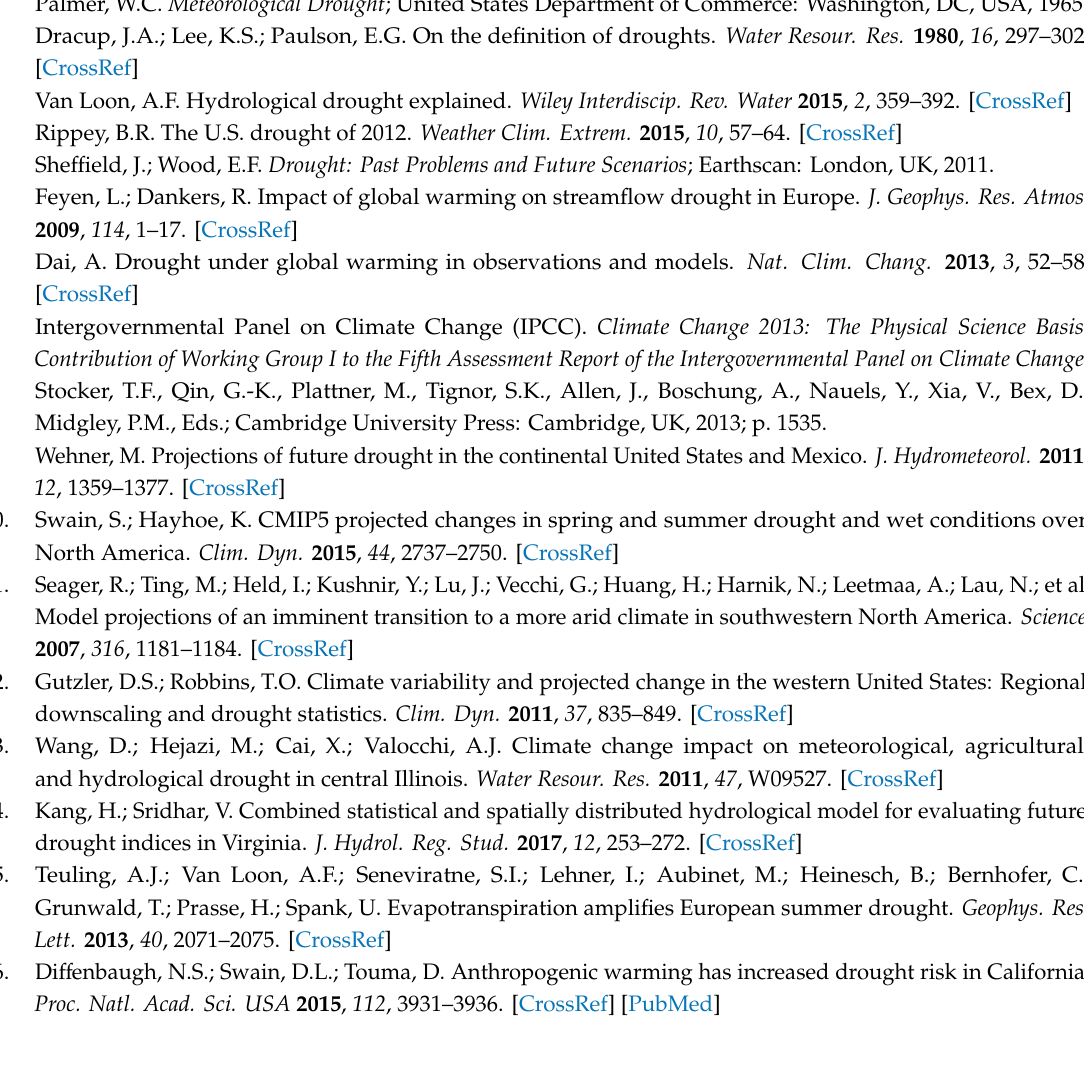
Table S8: Parameter modification method and initial ranges—Stage 2, Table S9: Calibration period error statistics, Table S10: Validation period error statistics, Table S11: Tabular version of Figure